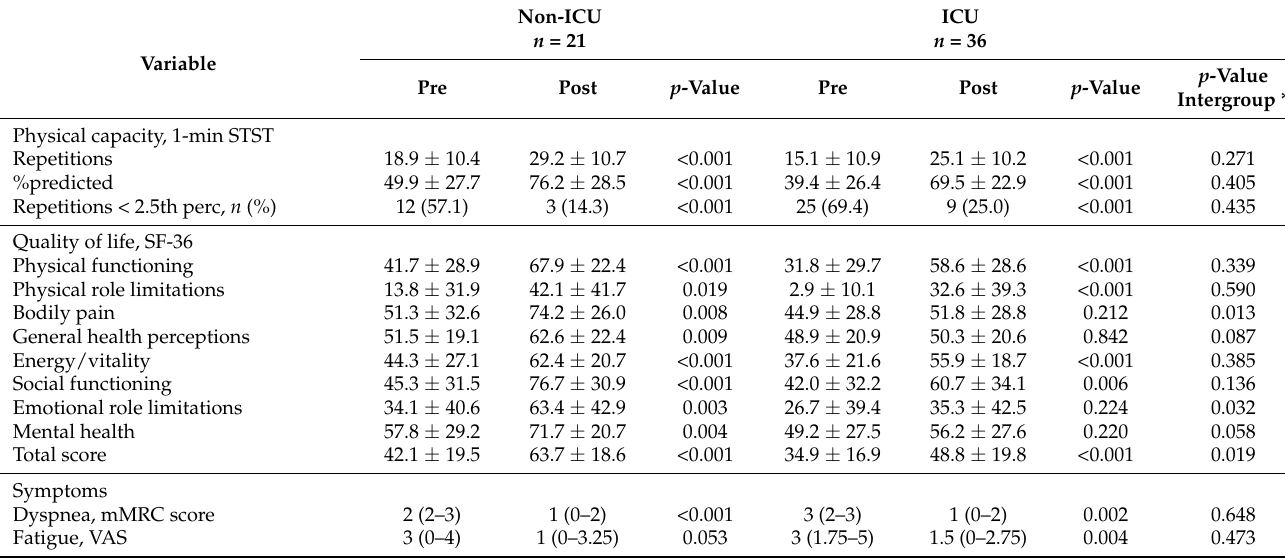
Table 3. Outcome measures results by ICU